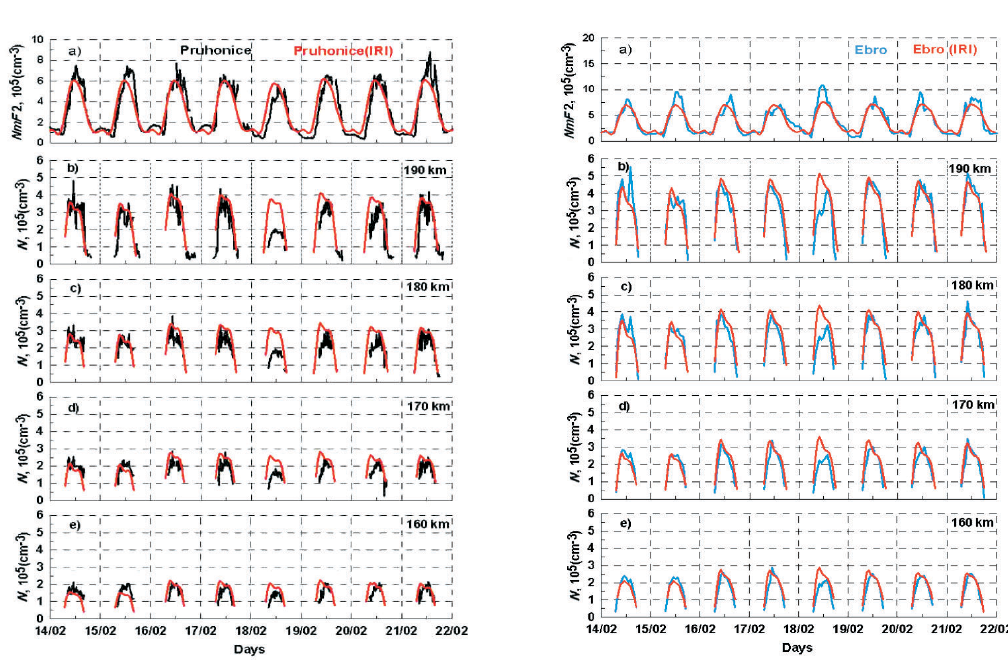
Fig. 3.9. Hourly NmF 2 values and electron density values at specific heights at Pruhonice ( left panel) and at Ebro ( right panel) stations during the period 14-21 February 1998. The output of the IRI model is shown in red, and observational data is shown in black (Pruhonice) or blue